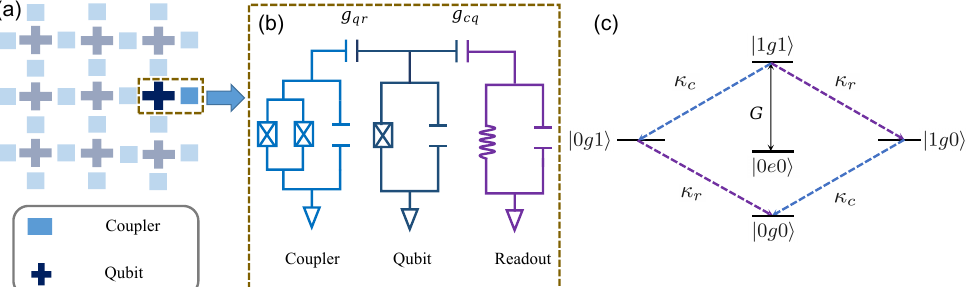
Figure 2. ( a ) The circuit diagrams of system model. Two-dimensional arrangement structure of the qubits and coupler and ( b ) circuit structure of specific system model. ( c ) Energy-level diagram of the qubit reset process. The coupling strength between | 0 e 0 (cid:105) and | 1 g 1 (cid:105) states is G ; and κ r and κ c denote the decay rates of readout resonator and coupler, respectively. Under the action of κ r and κ c , the | 1 g 1 (cid:105) state can rapidly decay to | 0 g 0 (cid:105)